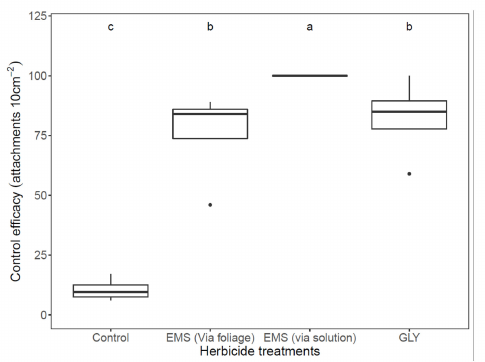
Figure 2. Control efficacy of P. aegyptiaca in cabbage grown hydroponically in polyethylene bags by applying the herbicide, glyphosate (GLY), or ethametsulfuron-methyl (EMS), before P. aegyptiaca attachment to the cabbage roots (vs. the non-treated control). Means were compared using GLM. ( p < 0.05); means labeled with the same letter do not show significant